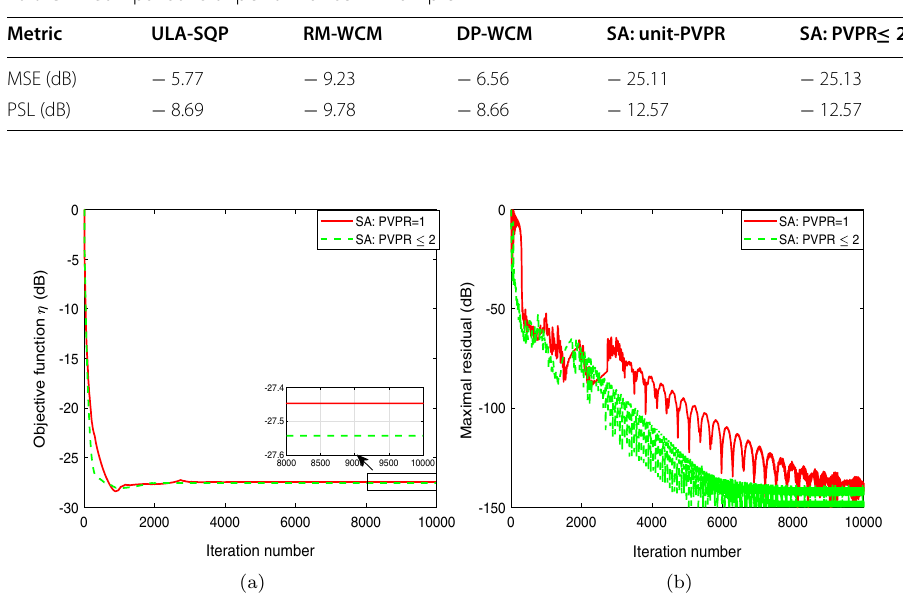
H x t v t p � 2 versus p −